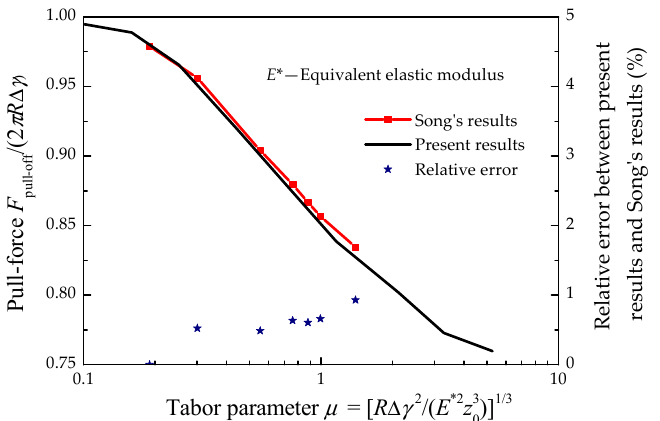
Figure 2. Comparison of the present numerical results with those of Song’s [21] for the elastic adhesive contact problem.